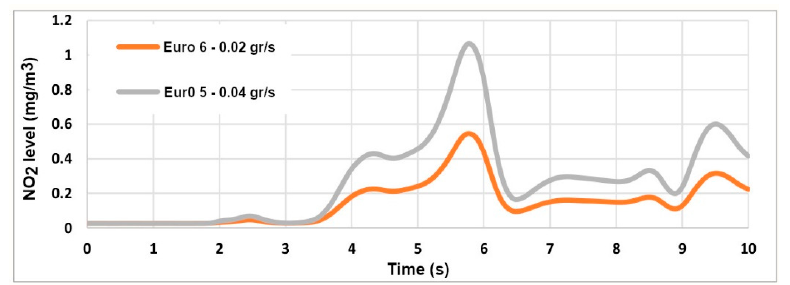
Figure 5. Comparison of NO 2 concentrations for the teenager pedestrian standing by the traffic light, for two different levels of tailpipe